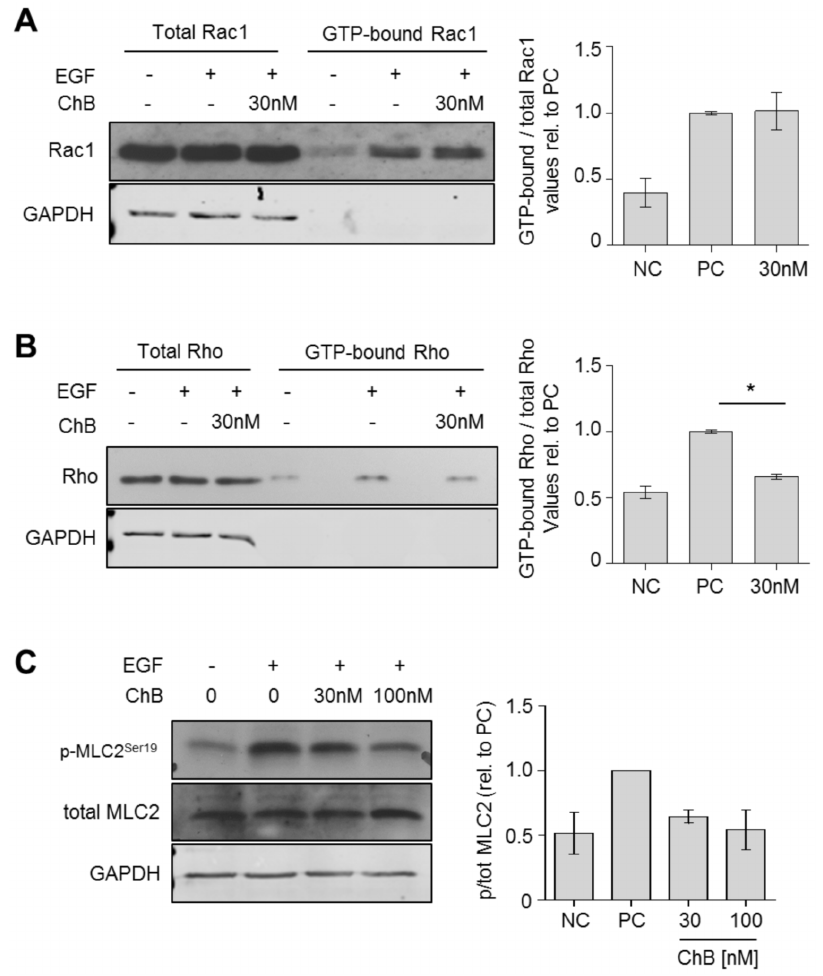
Figure 4. Chondramide affects activation of the RhoGTPase Rho. (A) A Rac1 pull down was performed for untreated and Chondramide treated cells (24 h) upon EGF-stimulation (5 min). (B) After same treatment a Rho pull down was conducted. (C) Myosin light chain 2 (MLC2) was analyzed on its activation state via Western blot analysis upon EGF stimulation (5 min). A,B,C: Left panel: one representative Western blot is shown. Right panel: Densitometric analysis of Western blots. *, p , 0.05 One-way ANOVA, Tukey post-test,